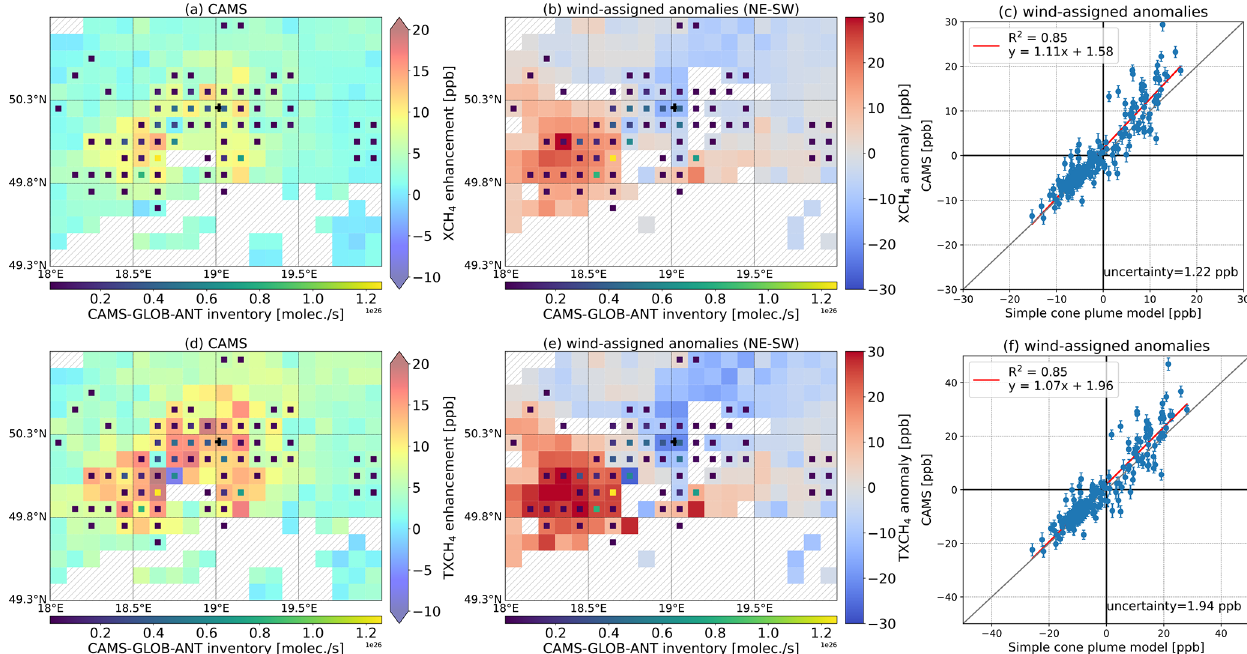
Figure 5. CAMS XCH 4 enhancement (XCH 4 -background) (a) , the wind-assigned anomalies (NE–SW) (b) , and correlation plot of the wind-assigned anomalies (c) between CAMS and the simple cone plume model with using the CAMS-GLOB-ANT inventory (9 . 7 × 10 26 molec.s − 1 in total) and ERA5 wind at 330m during November 2017–December 2020 over the USCB region. The same as for the upper panel are shown in (d–f) but for CAMS TXCH 4 . The square symbols represent the locations of the CAMS-GLOB-ANT ( > 1 × 10 24 molec.s − 1 ) inventory and different colors denote the amount of emission rates. The hatched areas in (a) – (b) and (d) – (e) repre- sent no data in these grids. The uncertainties in (c) and (f) represent the mean error bars, i.e., error propagation of the background uncertainty and the CAMS standard